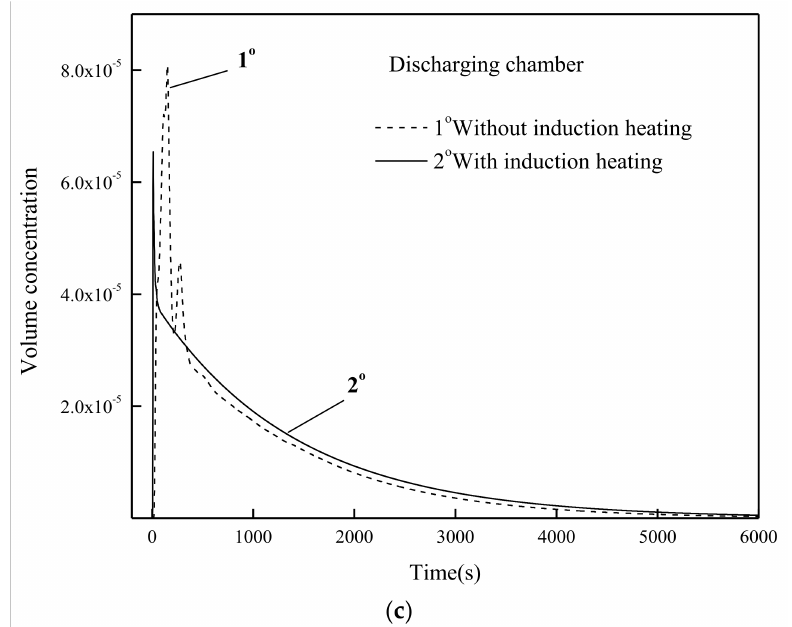
Figure 4. RTD curves for the tundish with and without channel induction heating. ( a ) RTD curve in the receiving chamber; ( b ) RTD curve in the channel; ( c ) RTD curve in the discharging chamber.